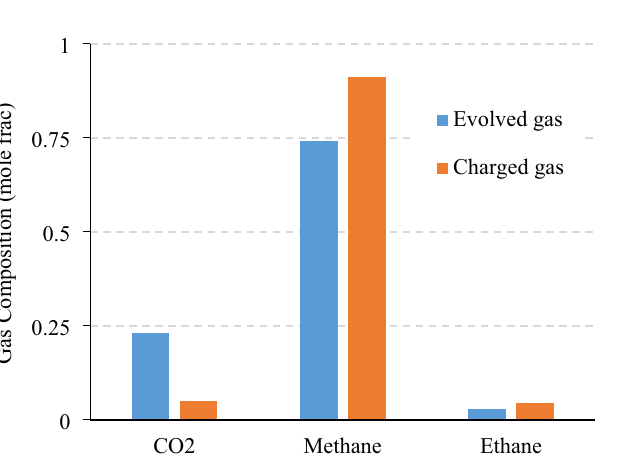
Figure 6. Composition of charged and evolved gases used and collected, respectively. The evolved or desorbed gas contained more CO 2 compared to the charged